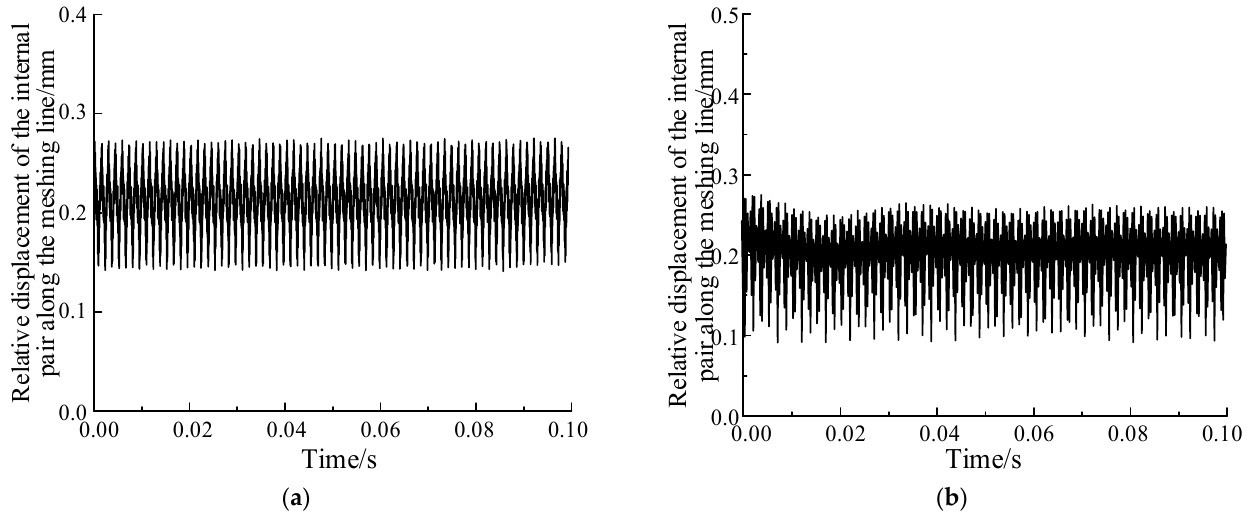
Figure 6. Compares the relative displacements of internal meshing pair along the meshing line before and after the flexibility of L-shaped ring gear and structural vibration. ( a ) Lumped mass method and ( b ) rigid-flexible coupling model.